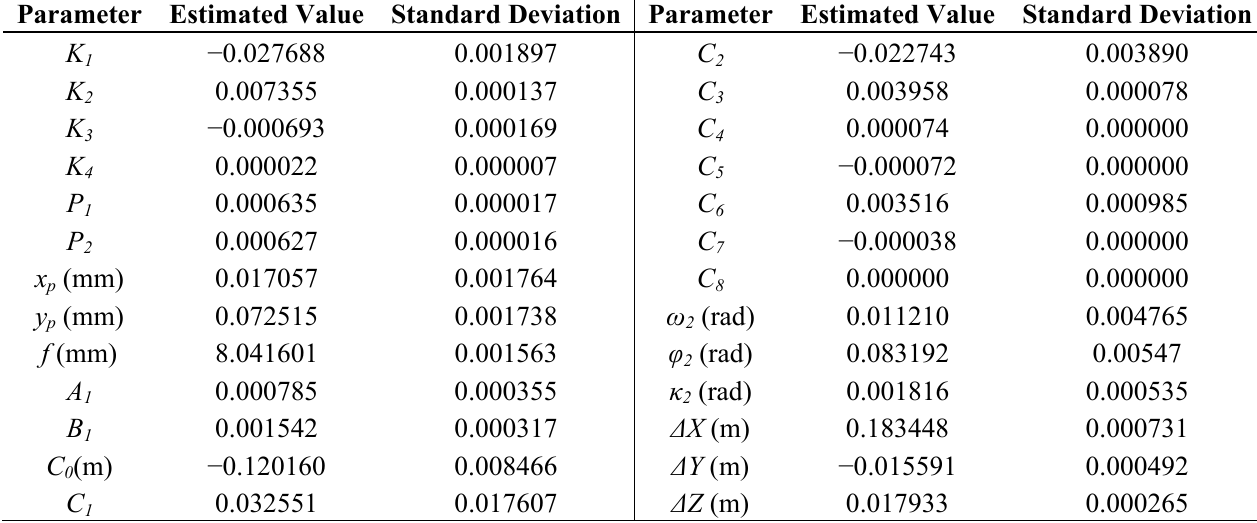
Table 4. Range camera calibration parameters from integrated joint